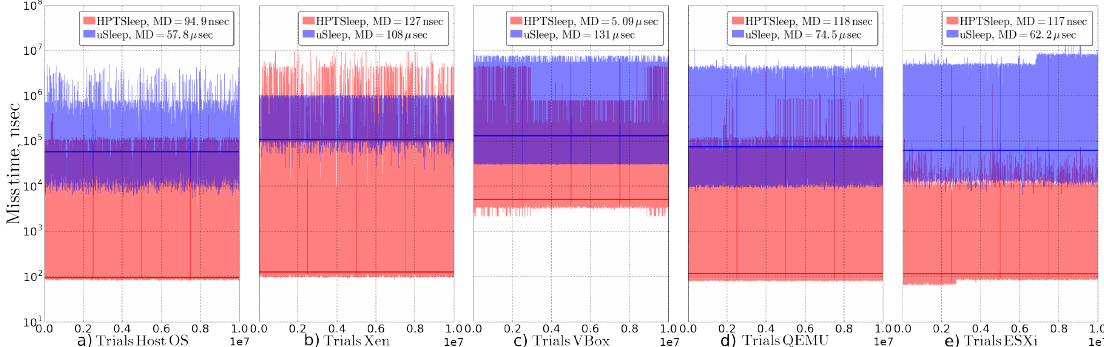
Figure 14. Measurements of miss time for the IO/network testbed on: ( a ) Host OS; ( b ) Xen; ( c ) Virtual Box; ( d ) QEMU; and ( e ) VMware